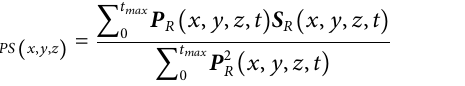
Frontiers in Earth Science |